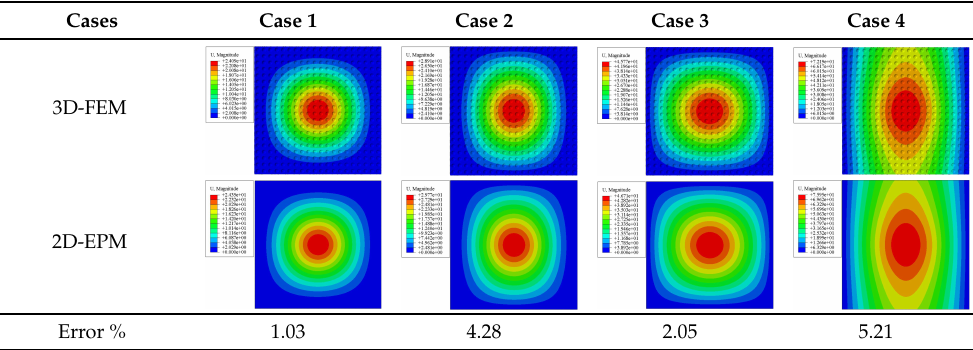
Figure 5. Four boundary conditions used in the static analysis of CCCP: ( a ) CCCC, ( b ) CSCS, ( c ) SSSS, and ( d ) SFSF, with C denoting clamped support, F for free support, and S for simple support. Table 1. Comparison of static displacement between 3D-FEM and 2D-EPM under different boundary conditions (unit: